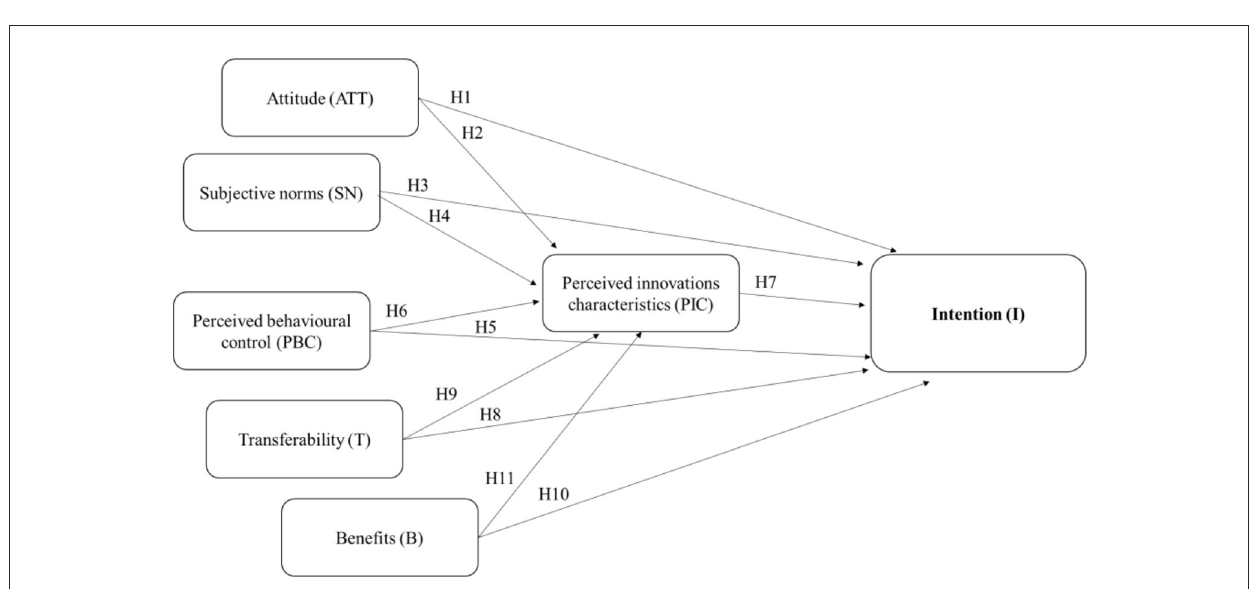
FIGURE2 Extended theory of planned behavior model*. *Our elaboration.